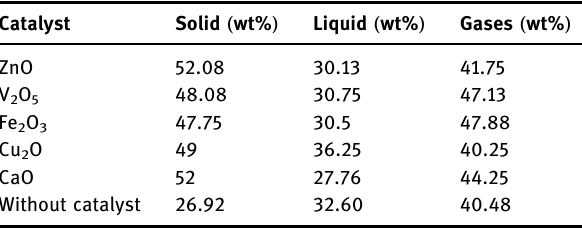
Table 3: Slow pyrolysis of navel orange peel with di ff erent